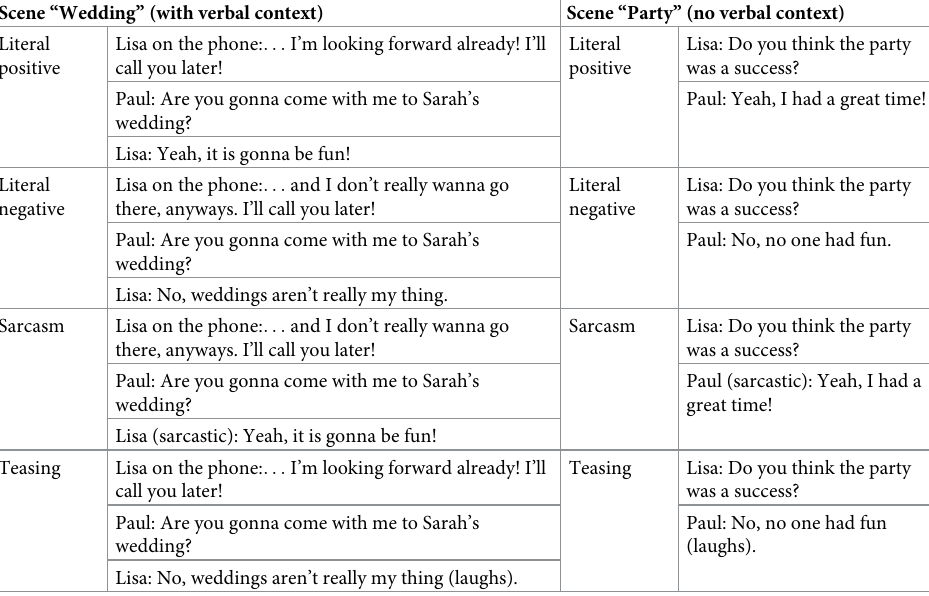
Table 2. Example scenes used in the experiment. Scene “Wedding” (with verbal